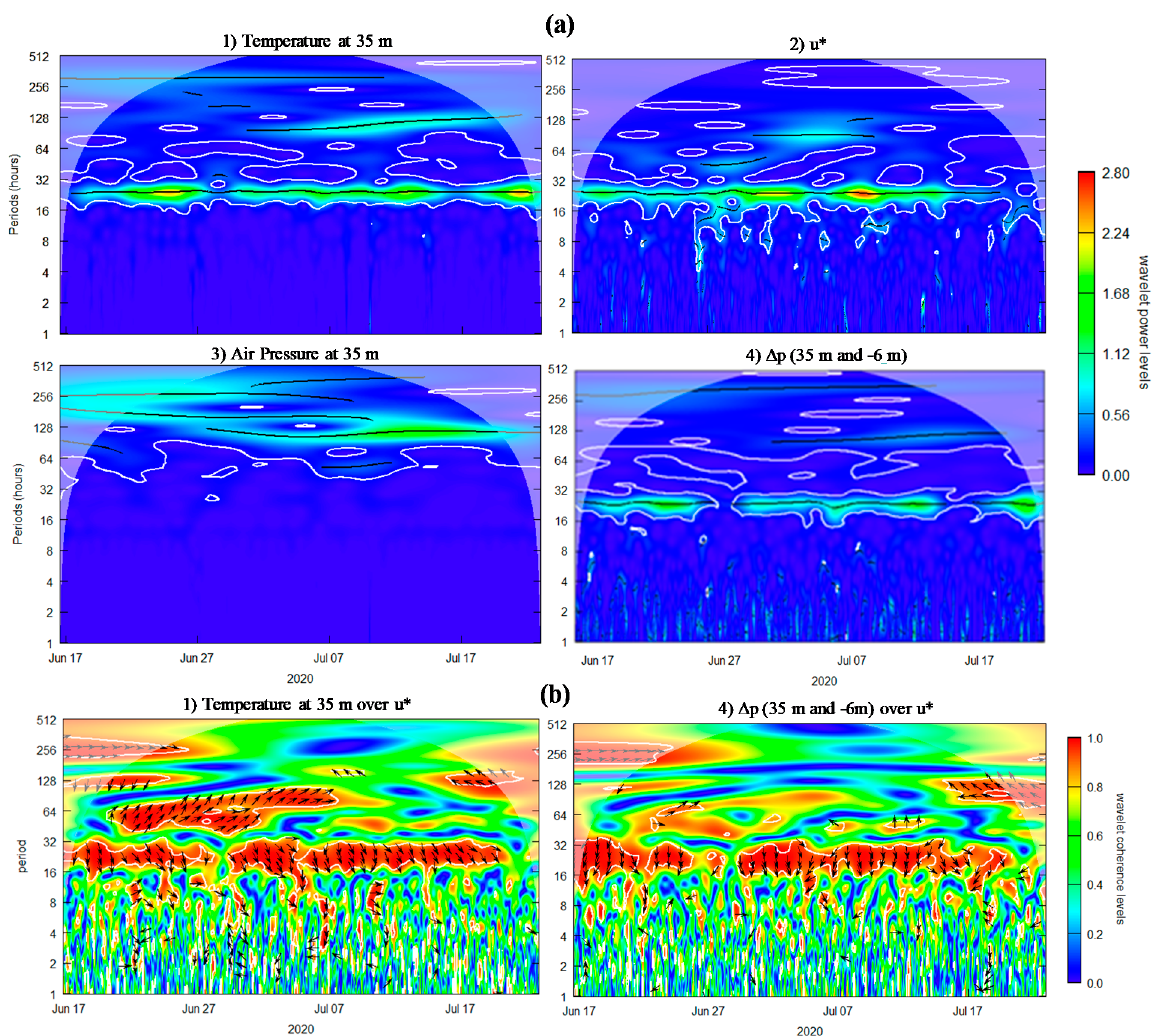
Figure 10. Half ‐ hourly wavelet ‐ based analysis from 17 June to 23 July 2020 which include ( a ) wavelet power spectrum of ( a1 ) temperature at 35 m, ( a2 ) friction velocity (u*), ( a3 ) air pressure at 35 m, and ( a4 ) air pressure difference ( ∆ p) between 35 m and − 6 m. Moreover, wavelet coherence analysis ( b ) shows the multivariate statistical significance of ( b1 ) temperature at 35 m over u* and ( b2 ) ∆ p over u*. In part, a reddish area and black lines represent high wavelet power levels. In part b, the red area with white contour lines demonstrates a high correlation with more than 5% significance levels. Arrows represent a multivariate phase ‐ locked angle relationship where horizontal arrows pointing left (phase angle: 180°) indicates that two wavelet series are out of phase and horizontal arrows pointing right (phase angle: 0°) suggests that two wavelet series are in phase. A white shaded area indicates that the time series are influenced by edge effects.